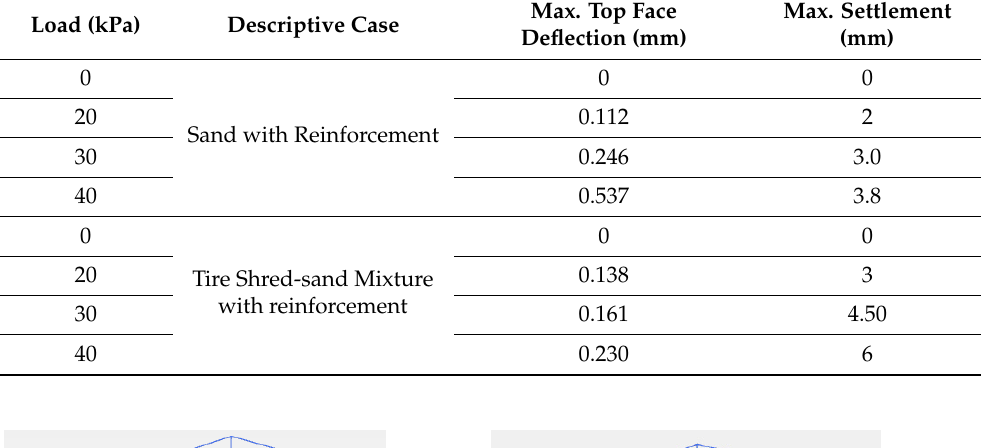
Table 4. Face deflection and max settlement for tire shred-sand mixture with reinforcement and for sand and reinforcement only.